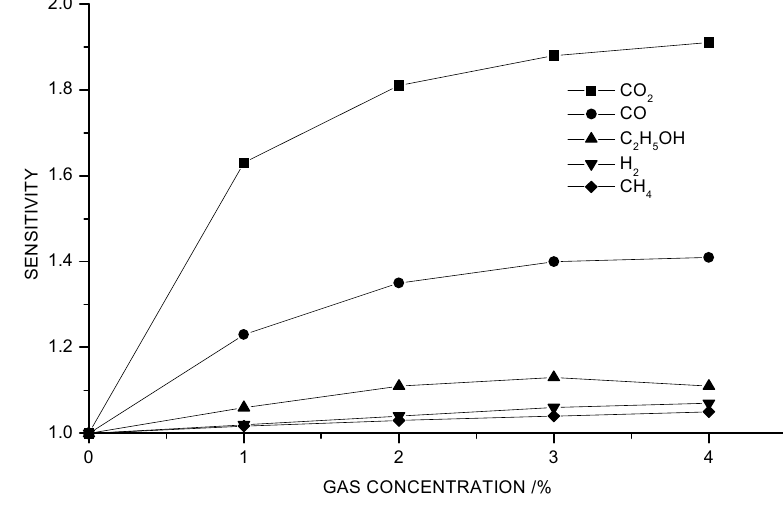
Figure 7. Selective characteristic of CuO-BaTiO